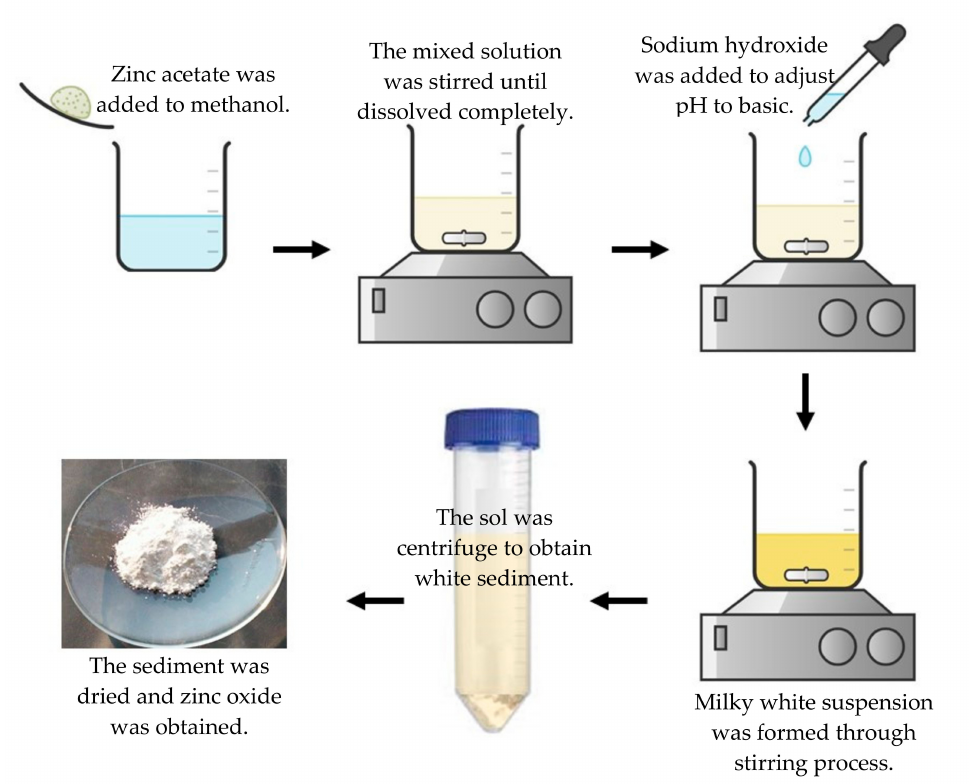
Figure 13. Illustration of ZnO photocatalyst preparation using a sol-gel technique.